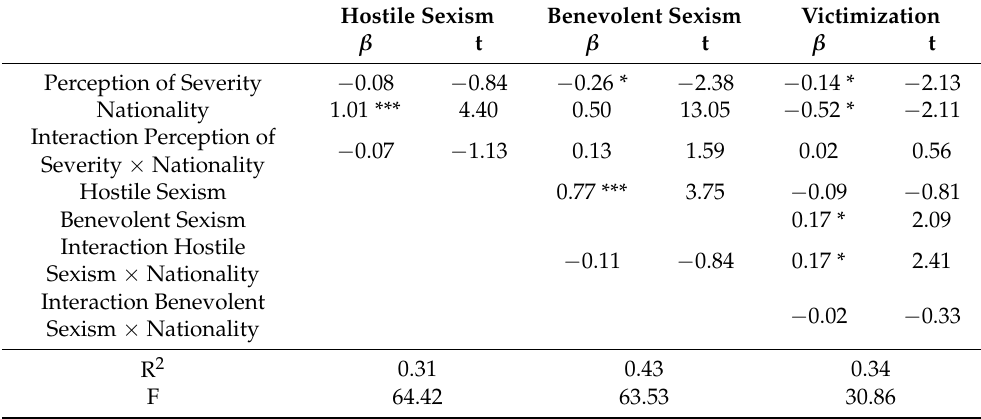
Table 5. Moderated mediation